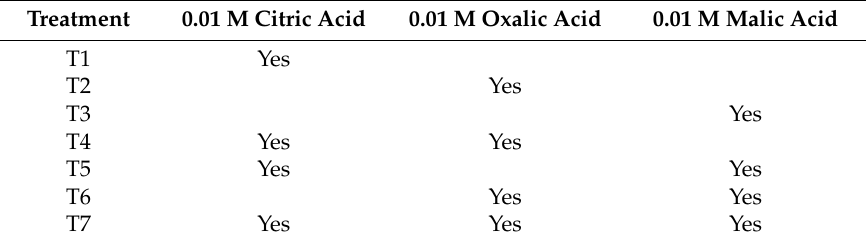
Table 2. Composition of extracting solutions for seven